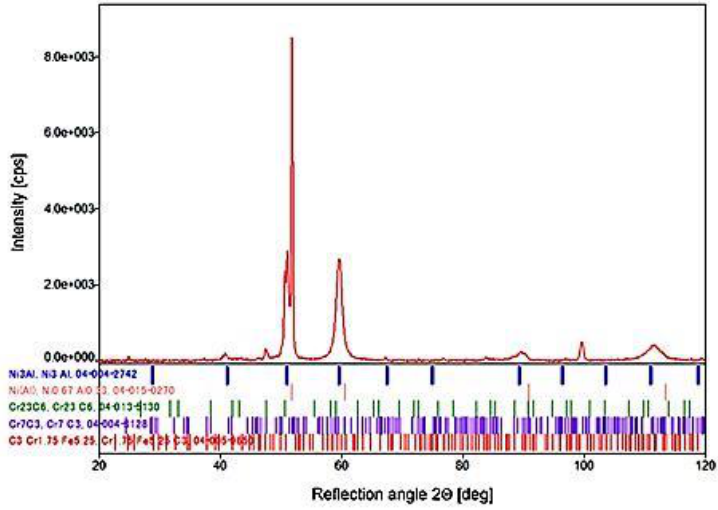
Figure 15. X-ray diffraction (XRD) pattern of the blade material with the identified phases.